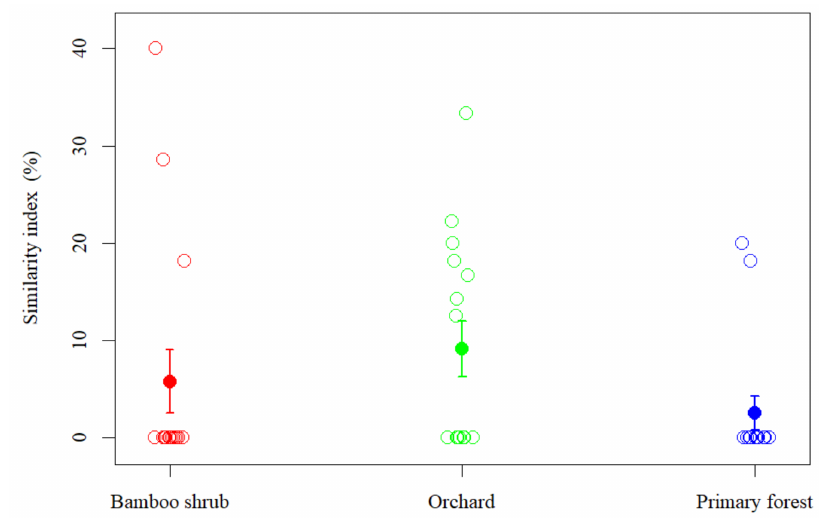
Figure 6. The Sørensen’s quotient of similarity between the SSB and aboveground vegetation in each vegetation type (mean ± standard error, n = 15).